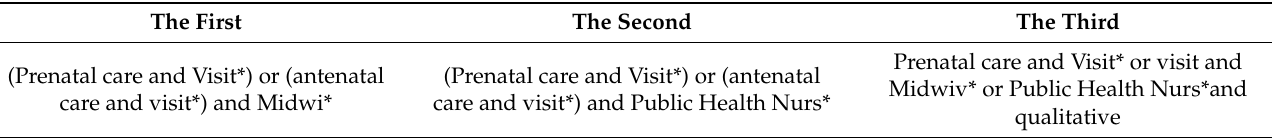
Table 2. Key terms for